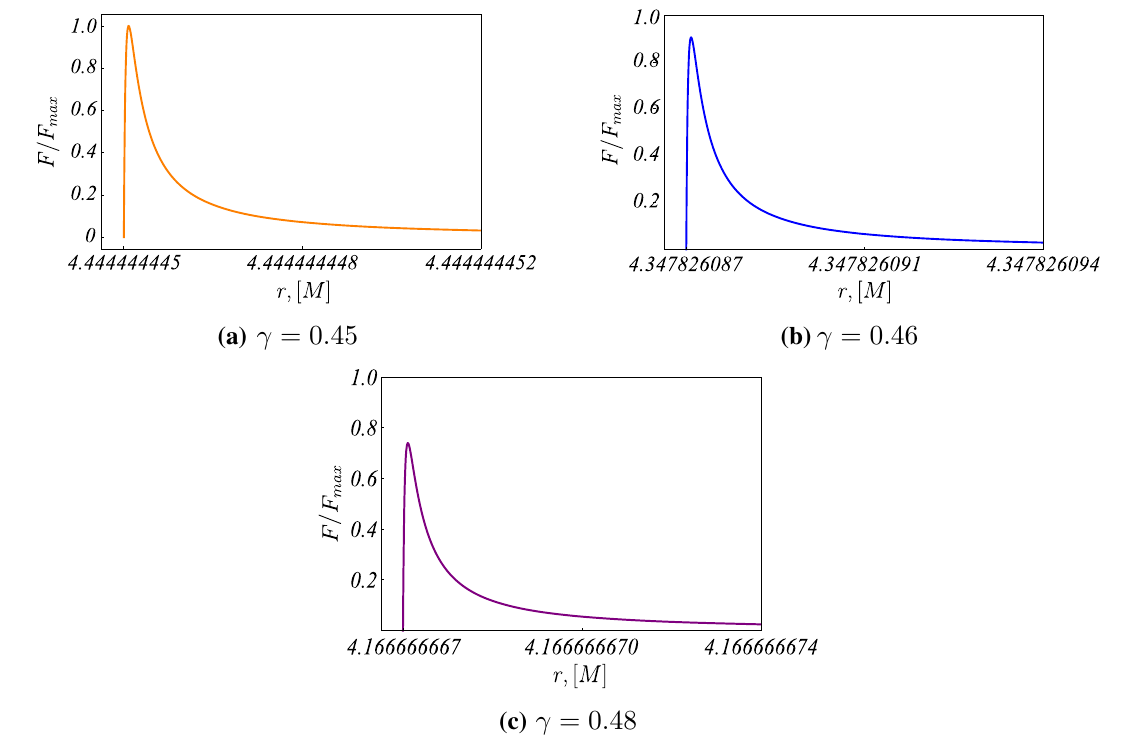
Fig. 17 Dependence of theradiationenergy flux ontheradialcoordinate for theinneraccretiondisk. Allthecurves arenormalizedby themaximum of the energy flux for γ = 0 . 45 F in max = 2 . 275 × 10 9 M ˙